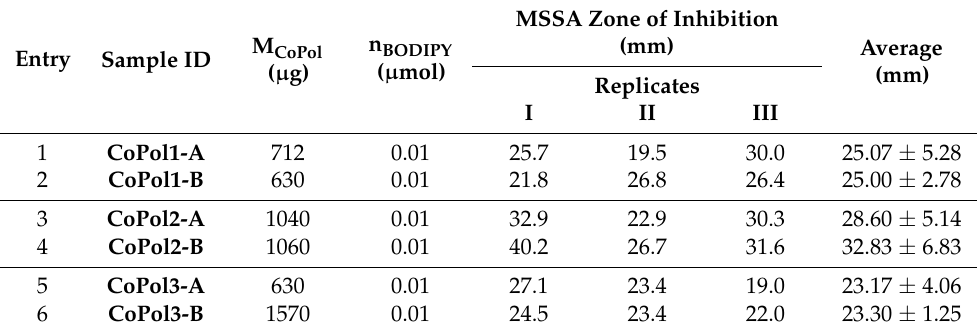
Figure 3. Representative images of antimicrobial assay on S. aureus ATCC 6538P. Bacterial cells were inoculated on LB agar and paper disks were placed on solid medium. Disks were prepared with polymers ( CoPol1 , CoPol2 , CoPol3 ) or polymers with BODIPYs A and B, respectively. After 2 h incubation at 37 °C, petri dishes were dark incubated or irradiated under green light. After overnight incubation at 37 °C, the antimicrobial activity was visible as a clear inhibition growth halo. The experiments were performed three times with independent bacterial cultures. Table 4. Antimicrobial activity in S. aureus ATCC 6538P. Diameters (mm) of inhibitory haloes are reported as mean ± sd of at least three independent assays.